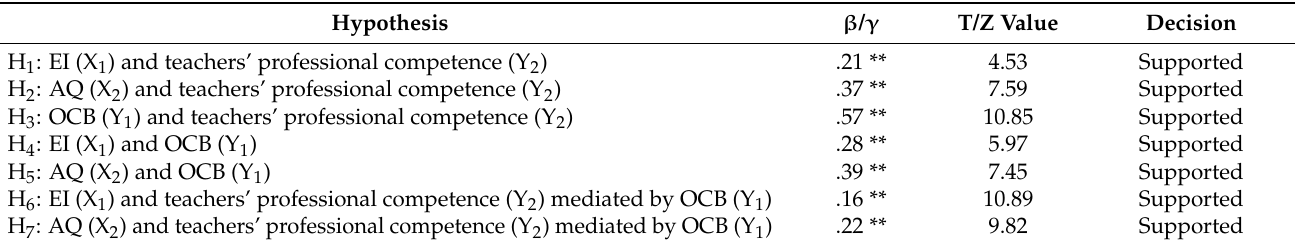
Table 5. Hypothesis testing